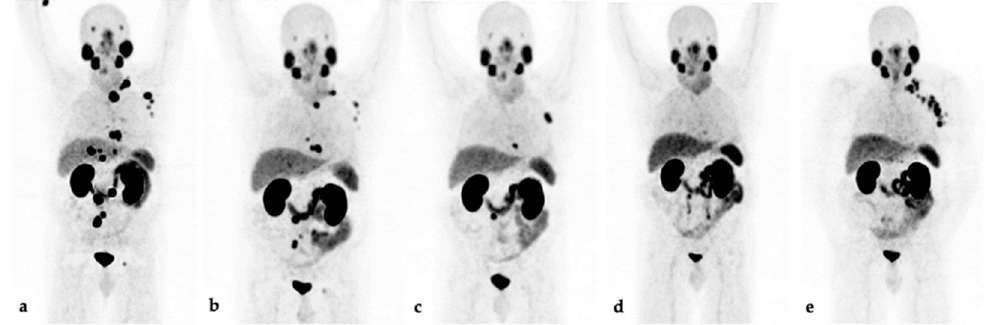
Figure 1. Maximum-intensity projections of 68 Ga-PSMA-11 PET/CT imaging of a metastasized castration-resistant EOPC patient during LuPSMA-RLT and follow-up. ( a ) At baseline, PSA: 69.3 ng/mL; ( b ) after three cycles, PSA at 12 weeks: 6.8 ng/mL; ( c ) after six cycles, PSA: 2.4 ng/mL; ( d ) after eight cycles, PSA: 0.3 ng/mL; ( e ) restaging 7 months later, PSA: 15.9 ng/mL. Among 14 (56%) patients with moderate to severe pain at baseline (defined as ≥ 4 pain level on a VAS assessment), 9/14 (64%) reported significant improvement of the overall pain (>2 level VAS decline) during LuPSMA-RLT or follow-up. Of 17 (68%)